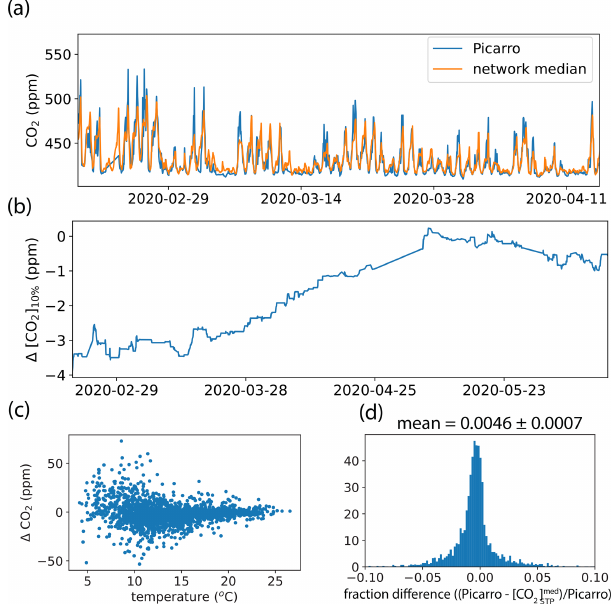
Figure 10. (a) CO 2 mixing ratios measured by the Picarro instru- ment at the Richmond Field Station (blue) and the median CO 2 of all Bay Area nodes having a temperature-dependent slope less than an absolute value of 1ppm ◦ C − 1 (orange). (b) The difference in the tenth percentile of CO 2 mixing ratios measured by the Picarro in- strument and the network median plotted versus date and (c) versus temperature. (d) Histogram of the fractional differences between Pi- carro CO 2 mixing ratios and the network median. Data for (c) and (d) include all of